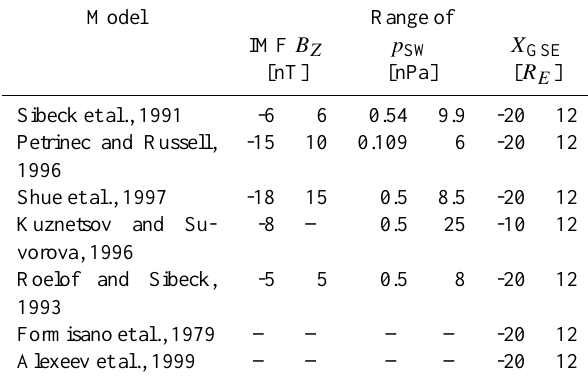
Table 1. Ranges of the validity of models Model